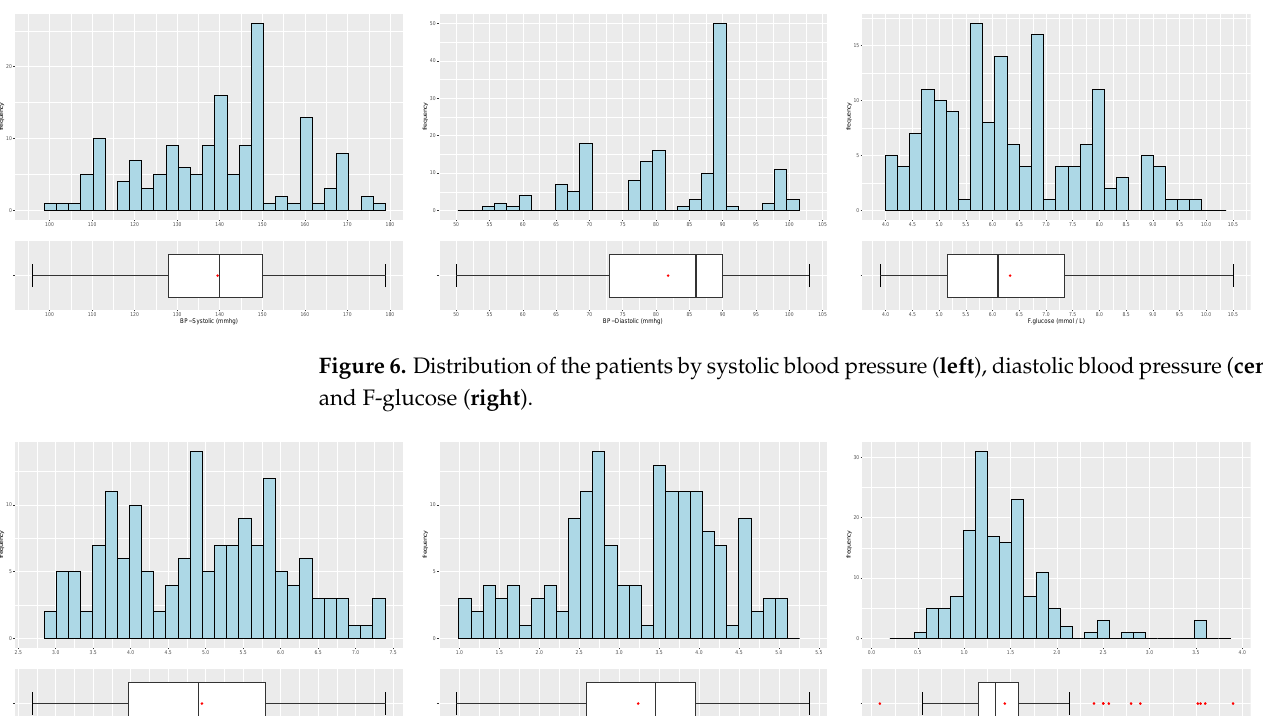
Figure 5. Distribution of the patients by age versus gender ( left ) and age versus diagnosis ( right ).